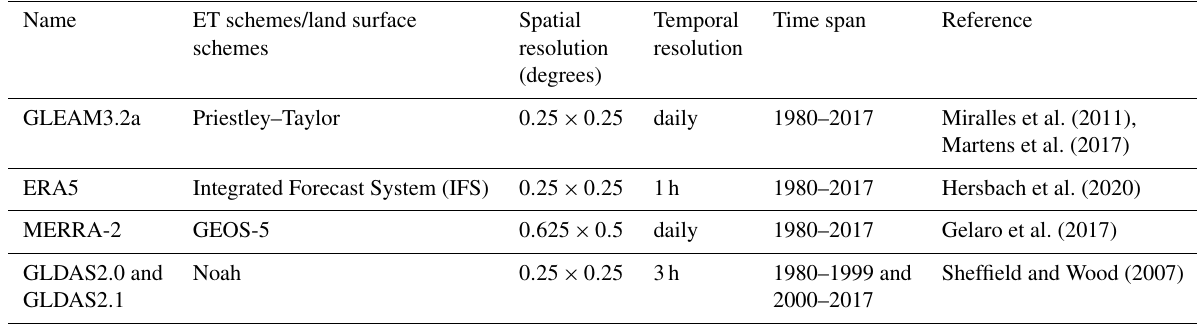
Table 1. Summary of ET datasets involved in